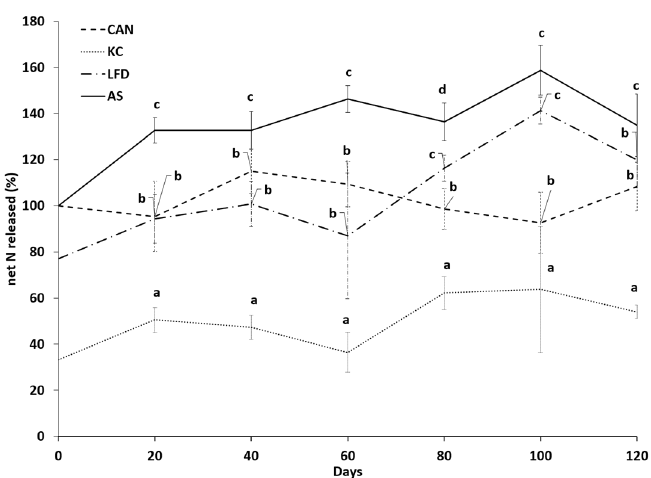
Figure 3. Net N release (in % of total N applied) for applied fertilisers over a time span of 120